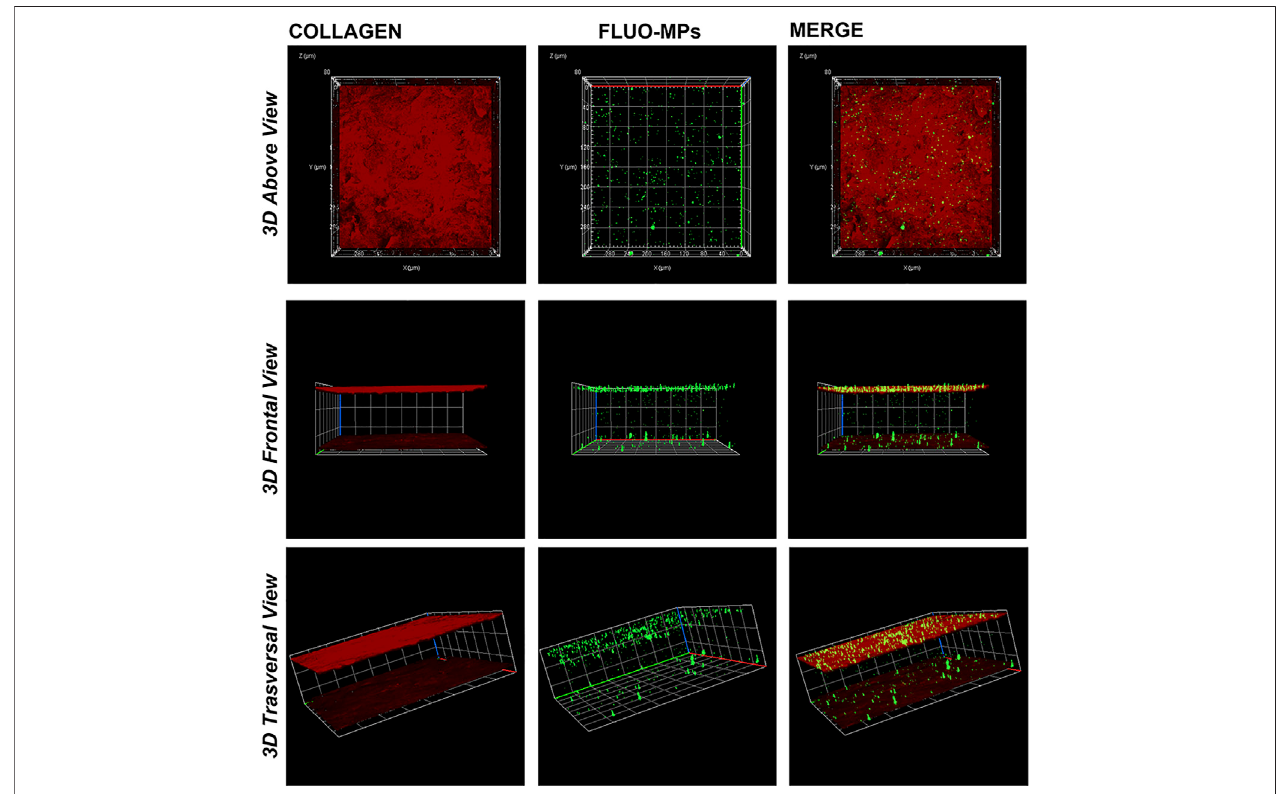
FIGURE 3 | Decellularized lenticule loaded with Fluo-MPs. Representative 3D (Z-stack; x , y and z axis) immuno fl uorescence images of decellularized lenticules engineered with Fluo-MPs. Lenticules were directly immunostained ex vivo following 5 h of incubation with Fluo-MPs suspension. Lenticules upper and lower surface were stained for collagen type I (in red). Fluo-MPs were visualized in green ( n = 6).